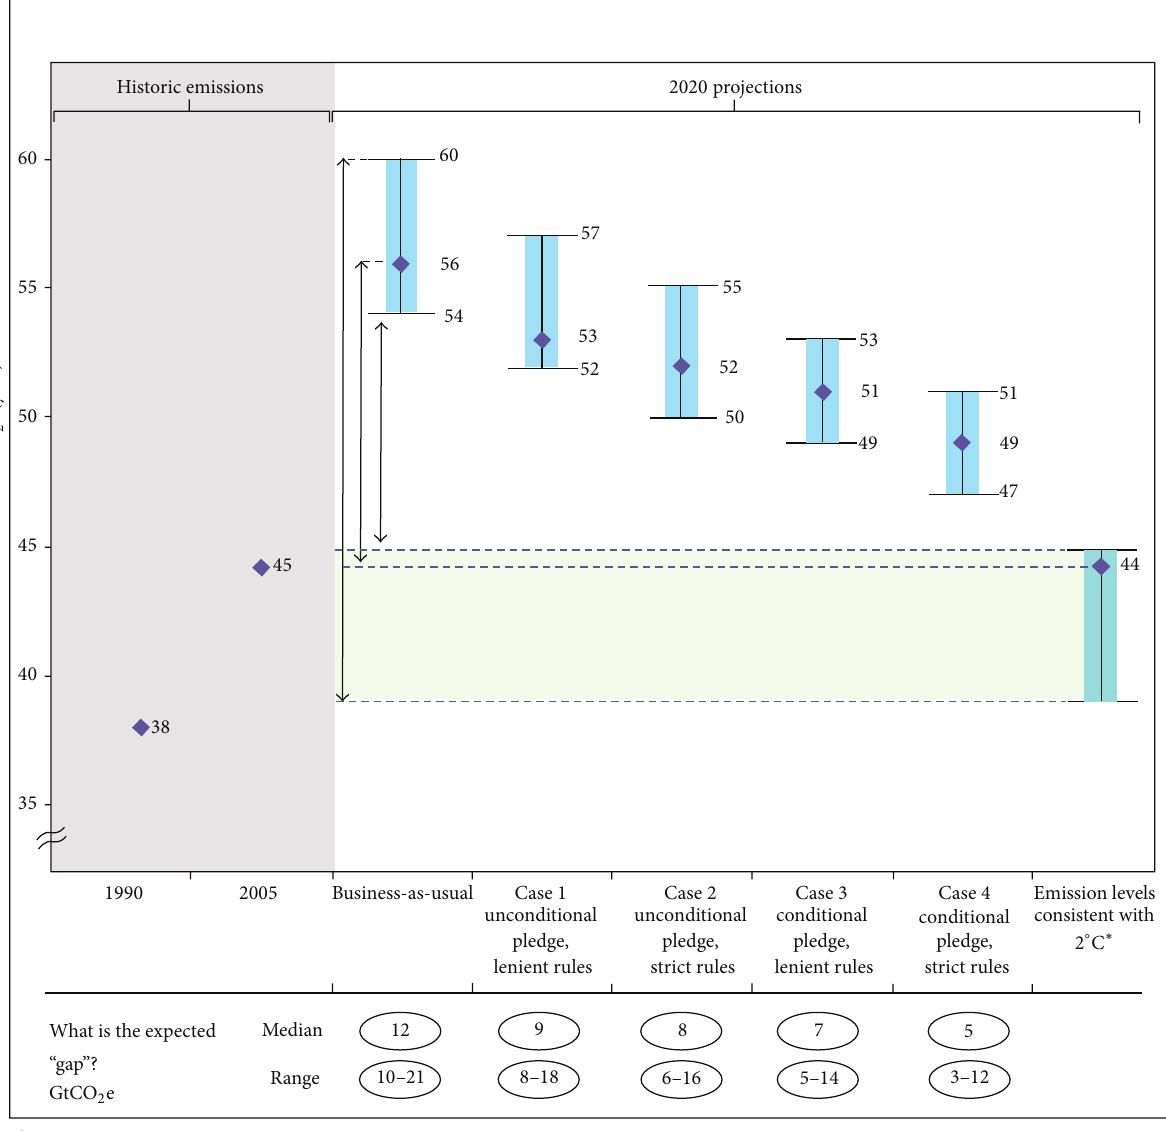
Figure 2: Comparison of expected emissions in 2020 with the emission levels consistent with a “likely” chance of meeting the 2 ∘ C limit [15]. The figure compares the expected emissions in 2020 resulting from the four pledge cases with the emission levels consistent with a “likely” chance of meeting the 2 ∘ C limit. The median estimates and range of estimates (20th to 80th percentile) are shown. The gap between expected emissions and the 2 ∘ C levels is given above in each